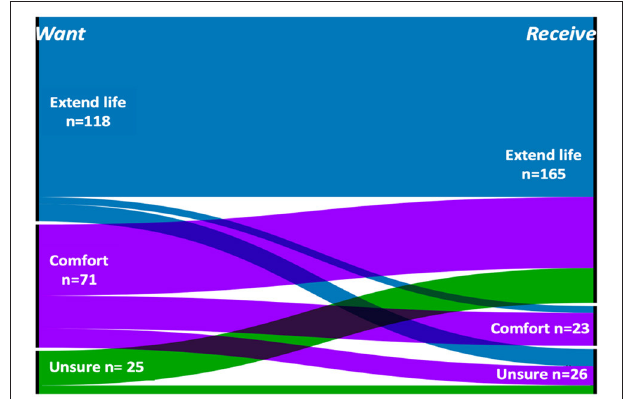
FIGURE 1 | Alluvial diagram illustrating Goal concordance at enrollment. Families were asked what goals of care the patient would prioritize (“Want,” left boarder) and what type of care the patient was receiving at that time (“Receive,” right boarder); n =